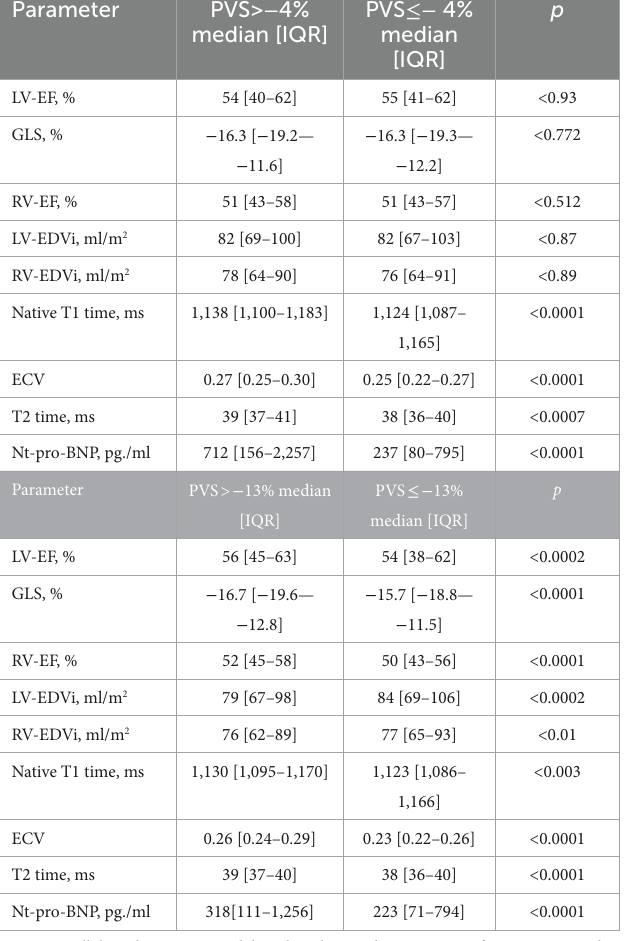
TABLE 3 Comparison of CMR parameters in patients with pathological PVS and normal PVS in the entire cohort. Parameter